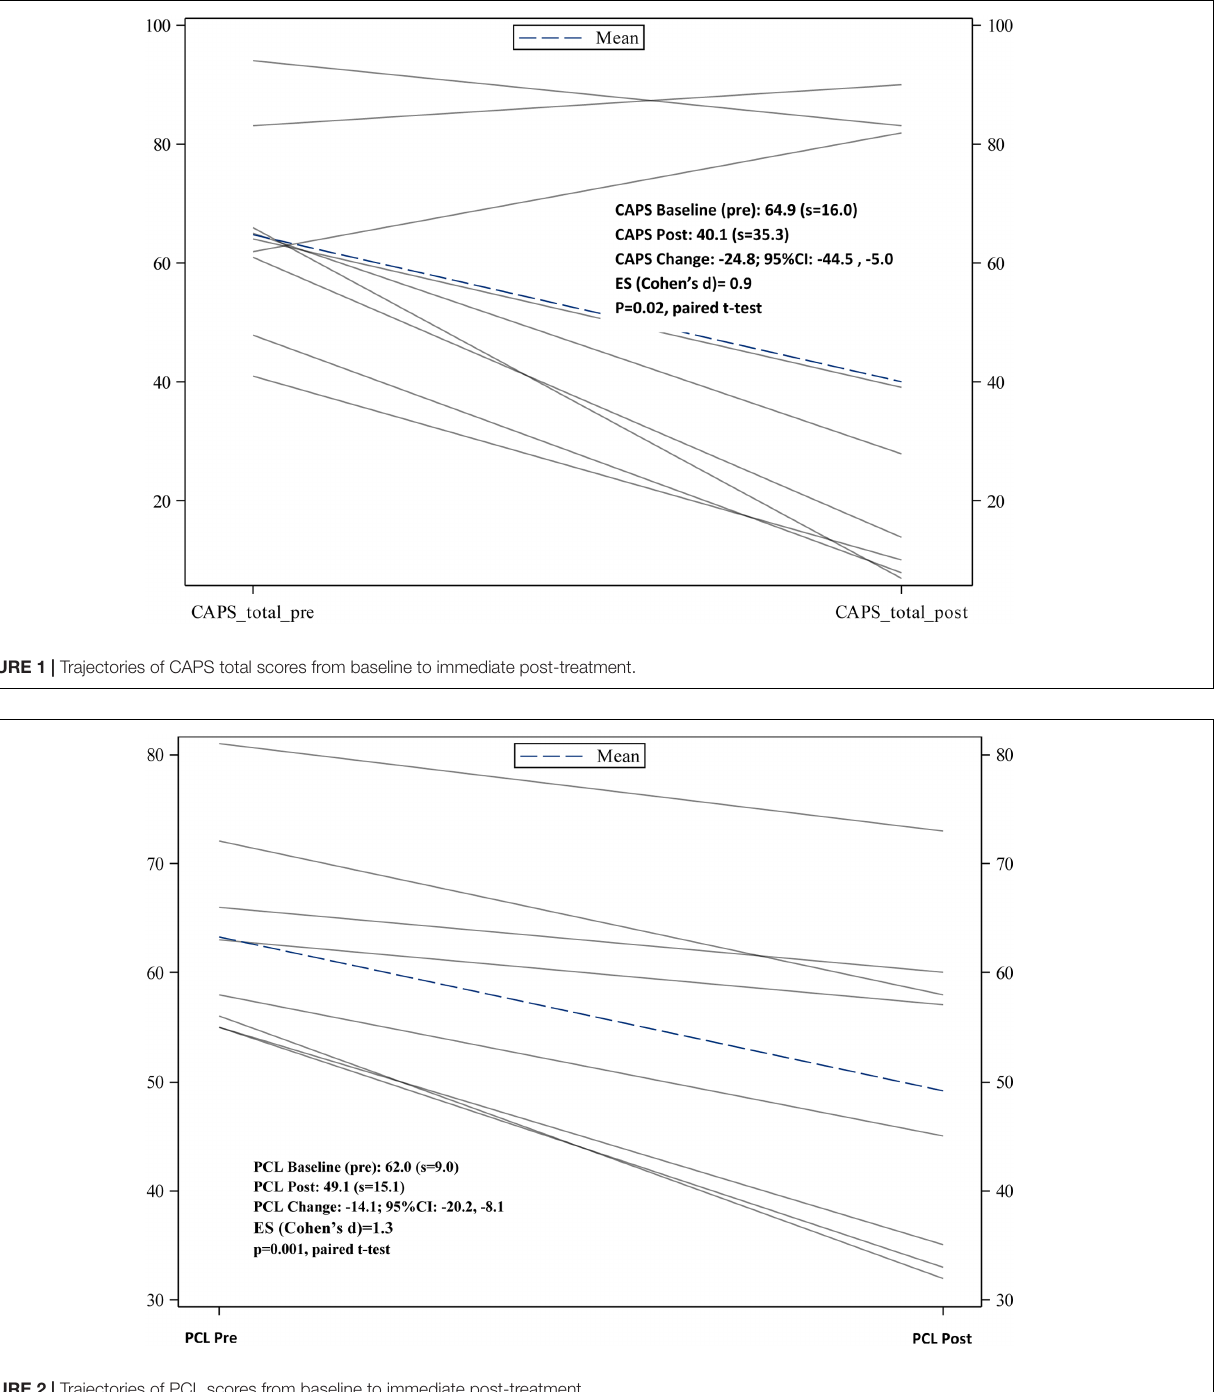
FIGURE 2 | Trajectories of PCL scores from baseline to immediate